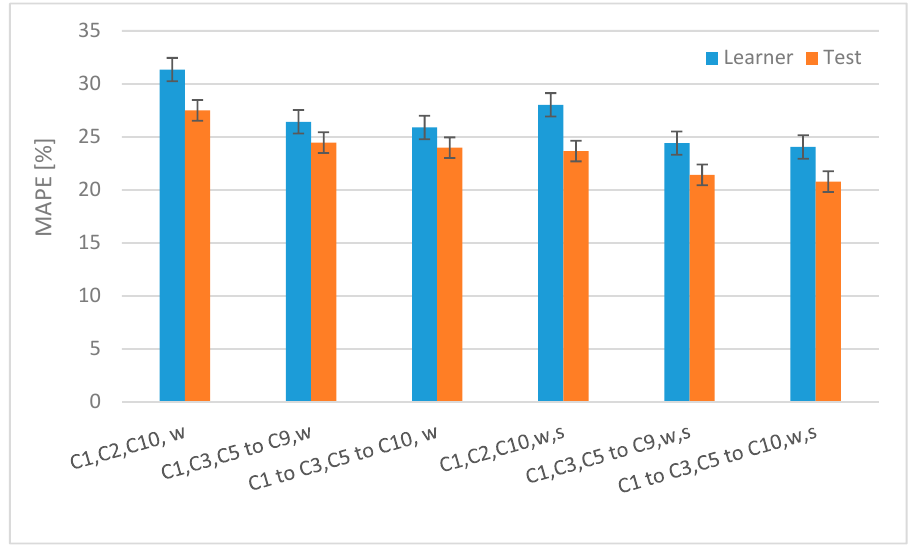
Figure 8. Assessment of the quality of the developed models of the total waste accumulation indicator for determined clusters in a varied system of input variables.